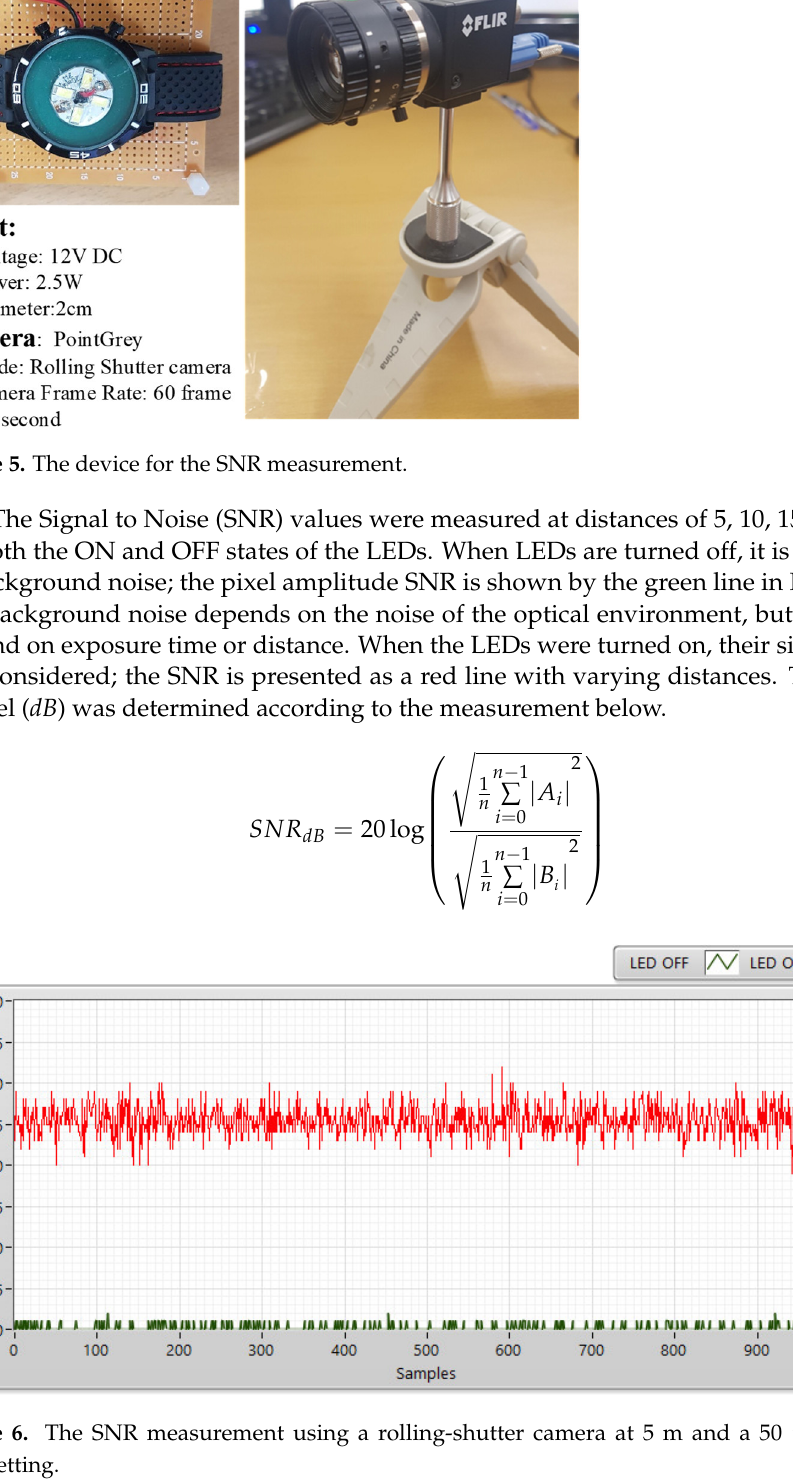
Figure 6. The SNR measurement using a rolling-shutter camera at 5 m and a 50 μs exposure-time setting.